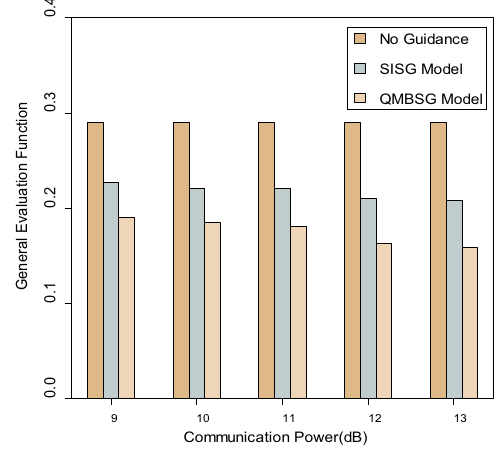
Figure 10 GEF of two speed guidance models for different